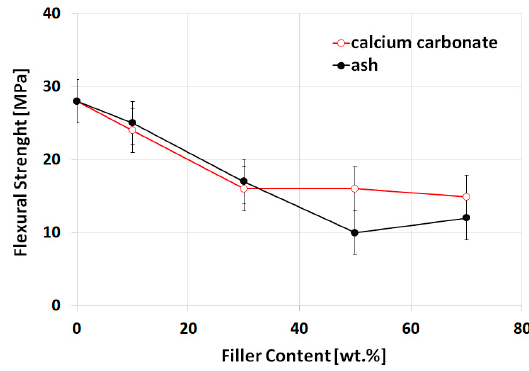
Figure 5. Flexural modulus as a function of filler content.